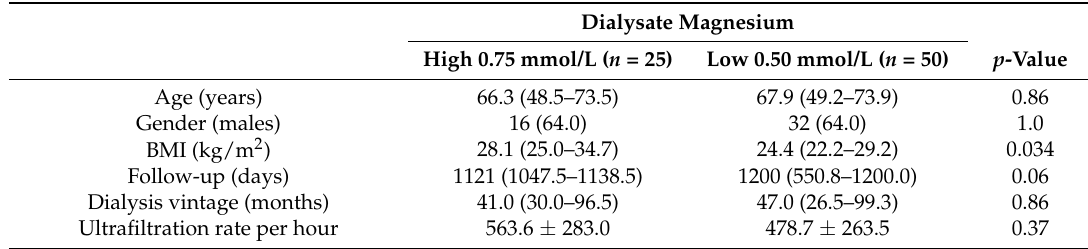
Table 1. Baseline characteristics in patients with high (0.75 mmol/L) vs. low (0.50 mmol/L) dialysate